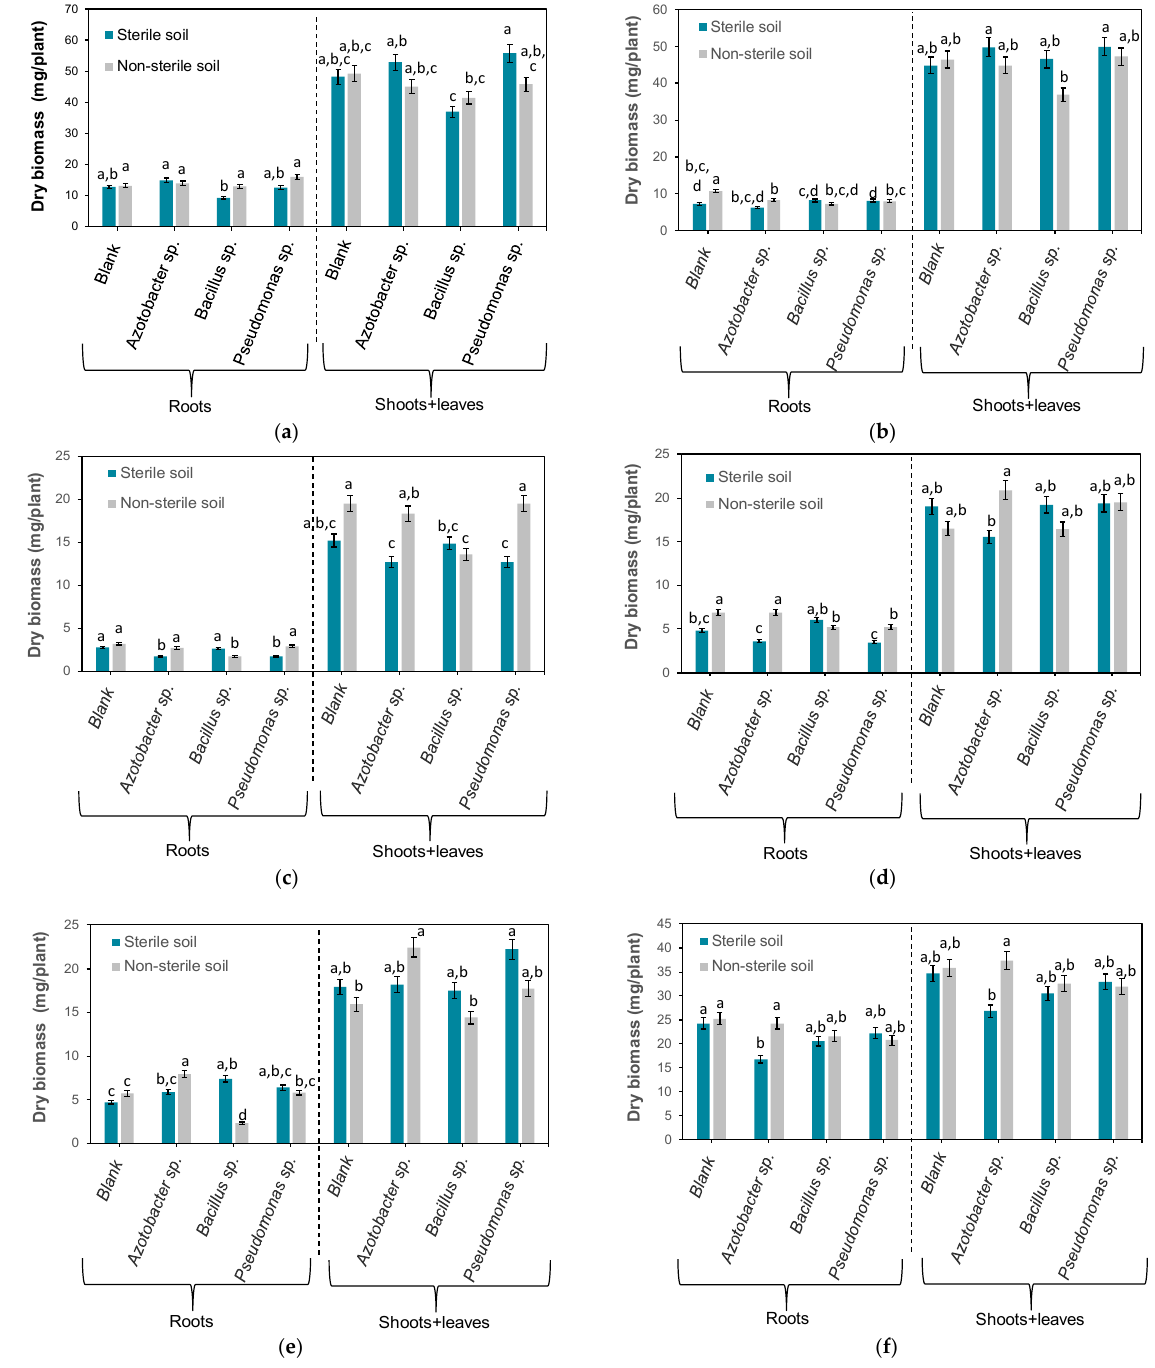
Figure 9. Effects of Azotobacter , Bacillus and Pseudomonas species on: ( a ) Sinapis alba L., ( b ) Brassica napus L., ( c ) Amaranthus retroflexus L., ( d ) Panicum miliaceum L., ( e ) Rumex patientia L. and ( f ) Linum usitatissimum L. on dry biomass weight after 25 days ( Sinapis alba L., Brassica napus L., Linum usitatissimum L., Panicum miliaceum L., Rumex patientia L.) and 30 days ( Amaranthus retroflexus L.) of growth (error bars represent the percentage error; means that do not share a letter are significantly different according to the Tukey’s HSD test).